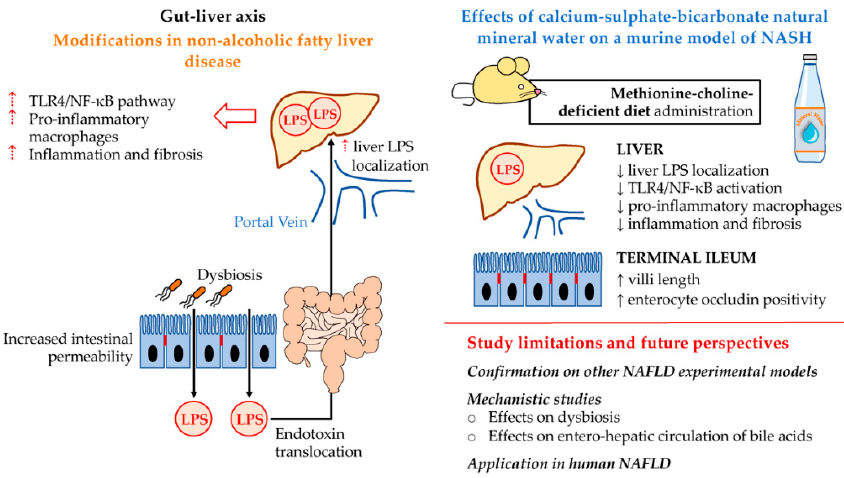
Figure 6. Framework figure. The gut–liver axis represents a key mechanism in nonalcoholic fatty liver disease (NAFLD) progression towards nonalcoholic steatohepatitis (NASH), triggering the activation of toll-like receptor (TLR) 4 and nuclear factor-k B (NF-kB) pathways in the liver via translocation of endotoxins (e.g., lipopolysaccharide: LPS). This is due to altered intestinal permeability and gut microbiota composition. In the present study, we investigated the effects of calcium-sulphate-bicarbonate natural mineral water on the methionine-choline-deficient diet model of NASH. Mineral water administration was associated with improvements in liver and terminal